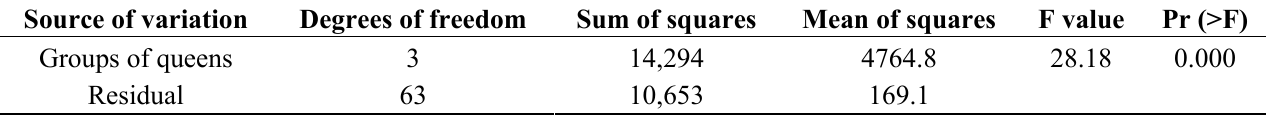
Table 1. Analysis of variance between infected and three control groups of